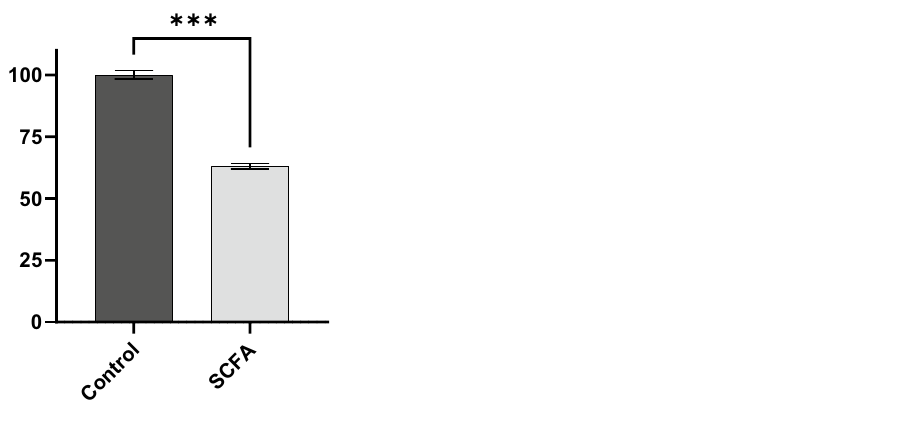
Figure 4. Effect of short-chain fatty acids on HDAC activity in primary microglia after LPS stimulation. Cells were pre-treated with SCFA mix (0 or 100 µM) for 4 h, and then stimulated with LPS (1 ng/mL) for 4 h. Control = cells stimulated with LPS and no pre-treatment with SCFA. Samples were analyzed by t-test with Welch’s correction. *** P < 0.001.